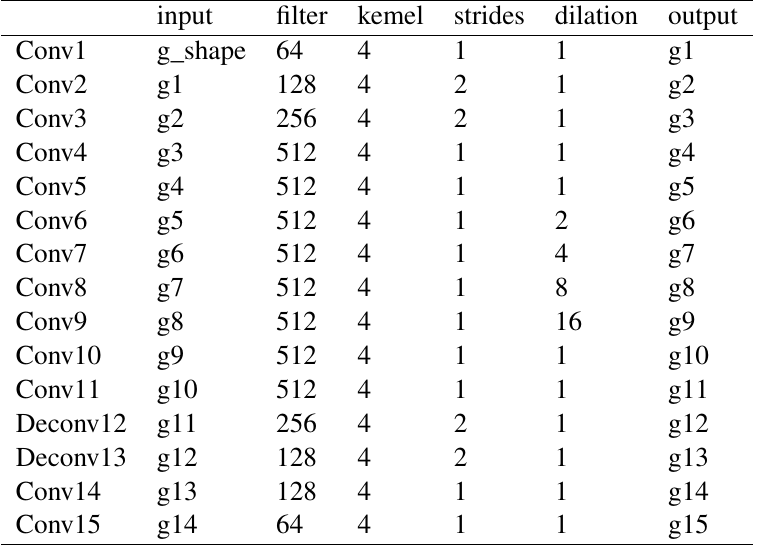
Table 2 Construction parameter list of generator G